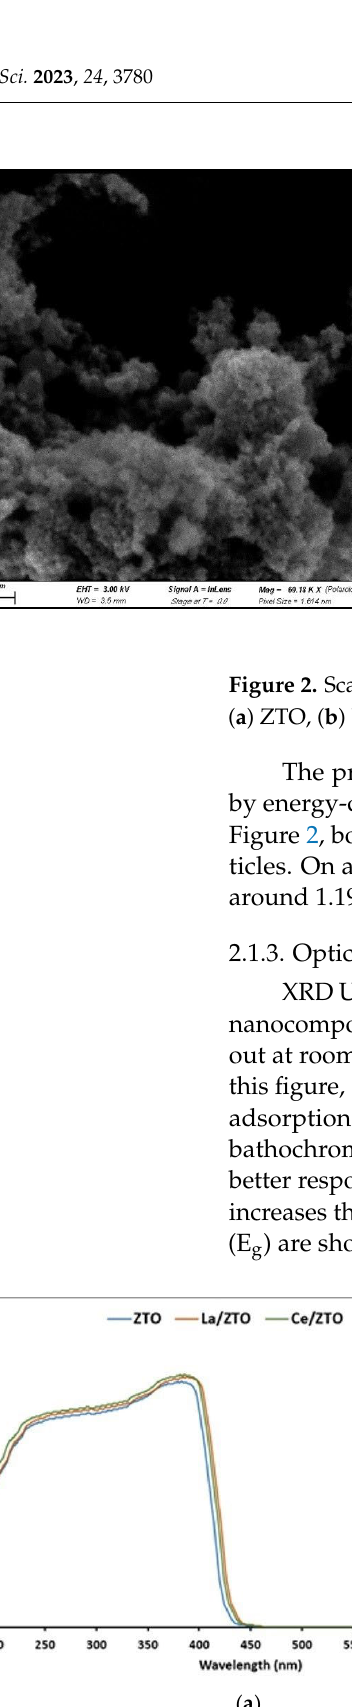
Figure 3. ( a ) UV-vis DRX and ( b ) plots of (αhv) 2 vs. E g of ZTO, La/ZTO, and Ce/ZTO.